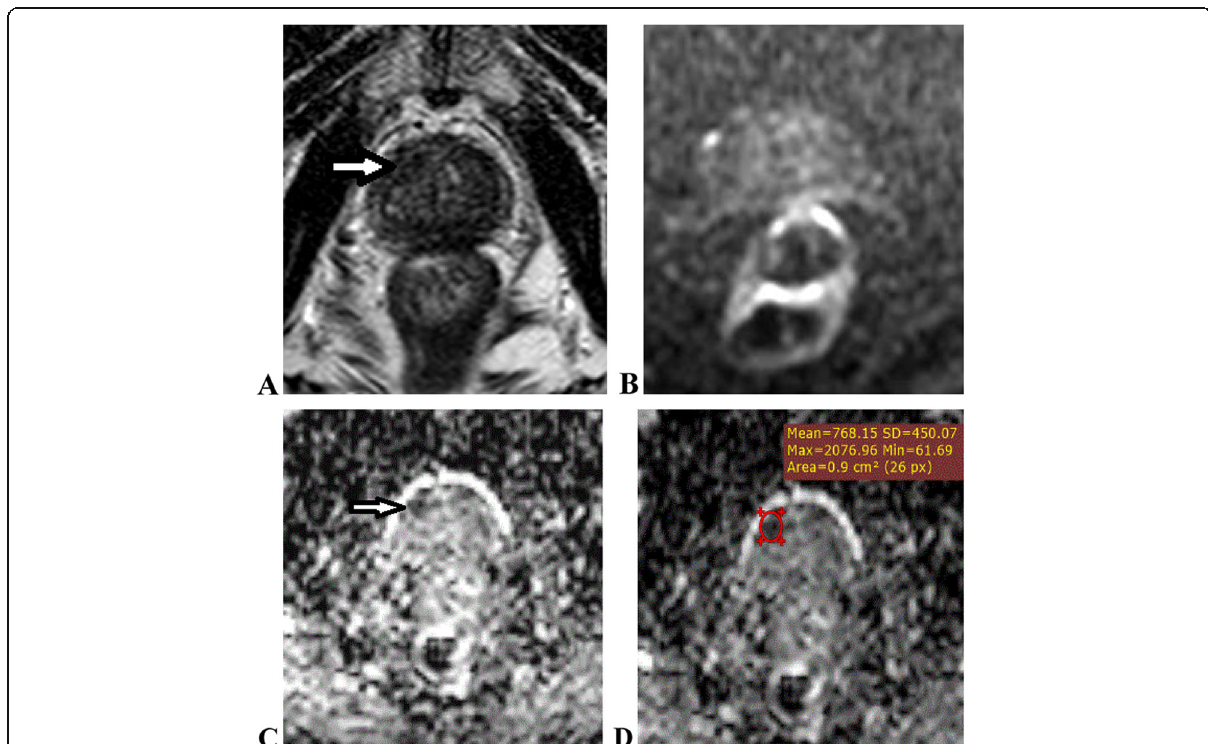
Fig. 5 A 76-year-old male patient with total PSA 318with discordant interpretation in terms of PIRADSv2 DWI score. a Axial T2 showing small hardly defined right sided transitional zone slightly low signal intensity lesion. B-DWI (at b value 800) the lesion was not well identified. b, d ADC map images showing mild low signal intensity of the lesion with mean ADC value 0.768. The DWI score was 3 for reader 1 and 3 for reader 2. The ADC ratio between benign prostatic tissues was 1.65. Histopathology was Adenocarcinoma GS 4 + 4 = 6; tumor volume = 0.6 cm 3 ;